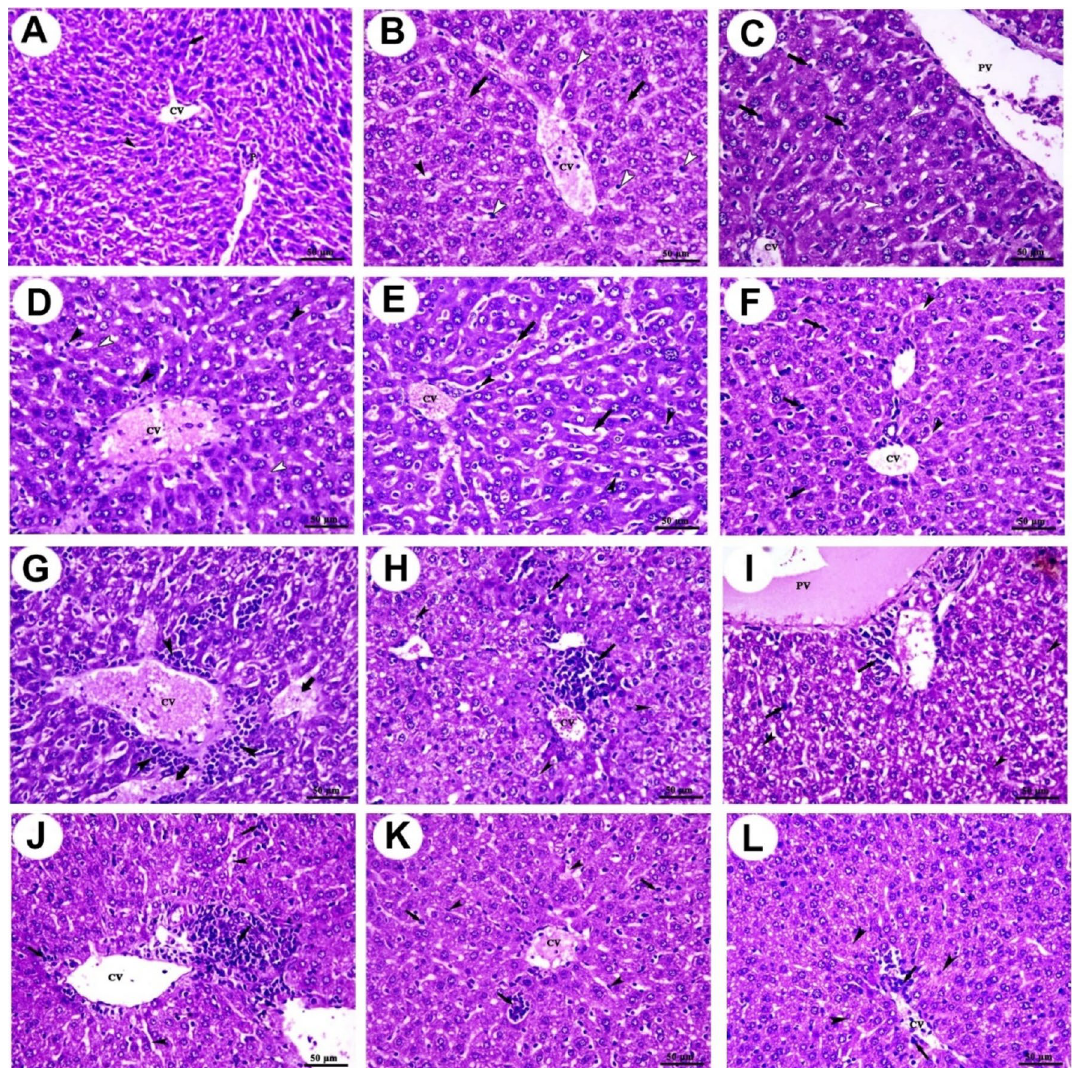
Figure 3. Photomicrographs of mice liver sections stained with H&E. ( A ) Control group shows central vein (CV), portal vein area (P), polyhedral-shaped hepatocytes (arrow), and blood sinusoids (arrowhead). ( B ) Amy group shows congested central vein (CV), mild dilation of blood sinusoids (black arrowhead), mild degeneration of hepatocytes (arrows), and mild Kupffer cells activity. ( C ) SorIP group shows congested central vein (CV), portal vein (PV), mild vacuolation of hepatocytes (white arrowheads), and moderate Kupffer cells activity (arrows). ( D ) SorOS group shows congested central vein (CV), mild vacuolation of hepatocytes (white arrowheads), and moderate Kupffer cells activity (black arrowheads). ( E ) Amy + SorIP group shows congested central vein (CV), congestion, and dilation of blood sinusoids (arrows) in addition to Kupffer cells activity (arrowheads). ( F ) Amy + SorOS group shows mild congestion of central vein (CV), mild dilation of blood sinusoids (arrowheads), and a moderate increase of Kupffer cells activity (arrows). ( G ) EAC group shows aggregations of pleomorphic, hyperchromatic, and darkly basophilic cells (arrowheads) around central vein (CV) and hepatocellular necrosis (arrows). ( H ) EAC + Amy group shows a moderate number of pleomorphic cells (arrows) with moderate degeneration (arrowheads). ( I ) EAC + SorIP group shows a small focal area of pleomorphic cells (arrows) with moderate degenerative changes (arrowheads). ( J ) EAC + SorOS group shows a moderate focal area of pleomorphic cells (arrows) and mild dilation of some blood sinusoids (arrowheads). ( K ) EAC + SorOS group shows the smallest focal area of the pleomorphic cells (arrows) with the mildest congestion in some blood sinusoids (arrowheads). ( L ) EAC + Amy + SorOS group shows small diffuse pleomorphic cells (arrows) with mild vacuolar degeneration of hepatocytes (arrowheads). Scale bars = 50